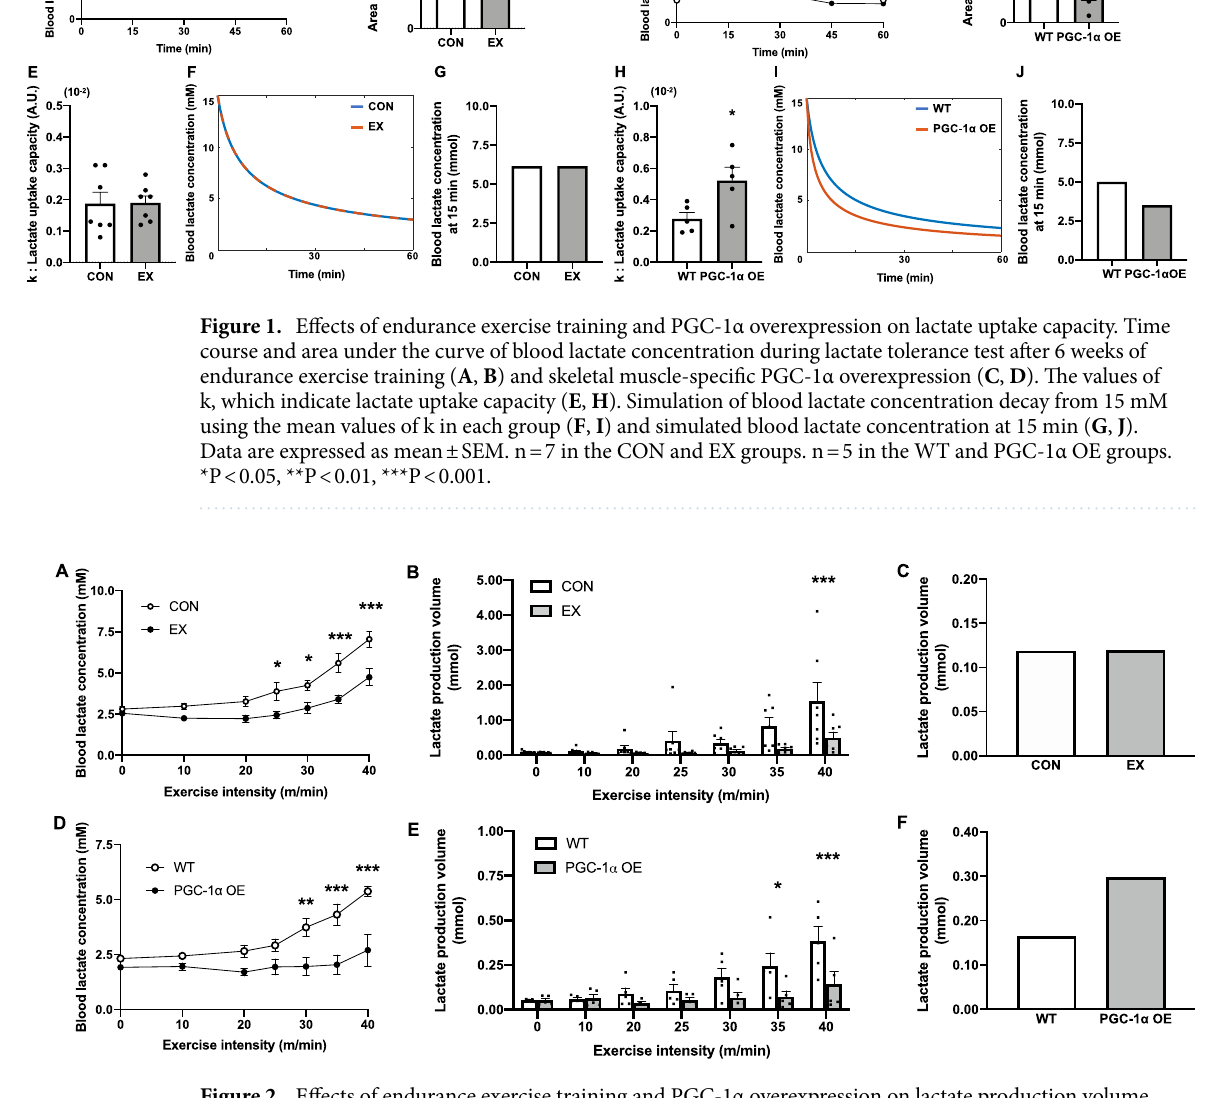
Figure 2. Effects of endurance exercise training and PGC-1α overexpression on lactate production volume. Blood lactate concentrations of CON and EX or WT and PGC-1α OE at each exercise intensity during incremental exercise test ( A , D ). The lactate production volume during a 2-min exercise calculated using Eq. (2) utilizing the experimental data ( B , E ). Simulated lactate production volume in response to 4 mM blood lactate concentration in each group ( C , F ). Data are expressed as mean ± SEM. n = 7 in the CON and EX groups. n = 5 in the WT and PGC-1α OE groups. *P < 0.05, **P < 0.01, ***P <